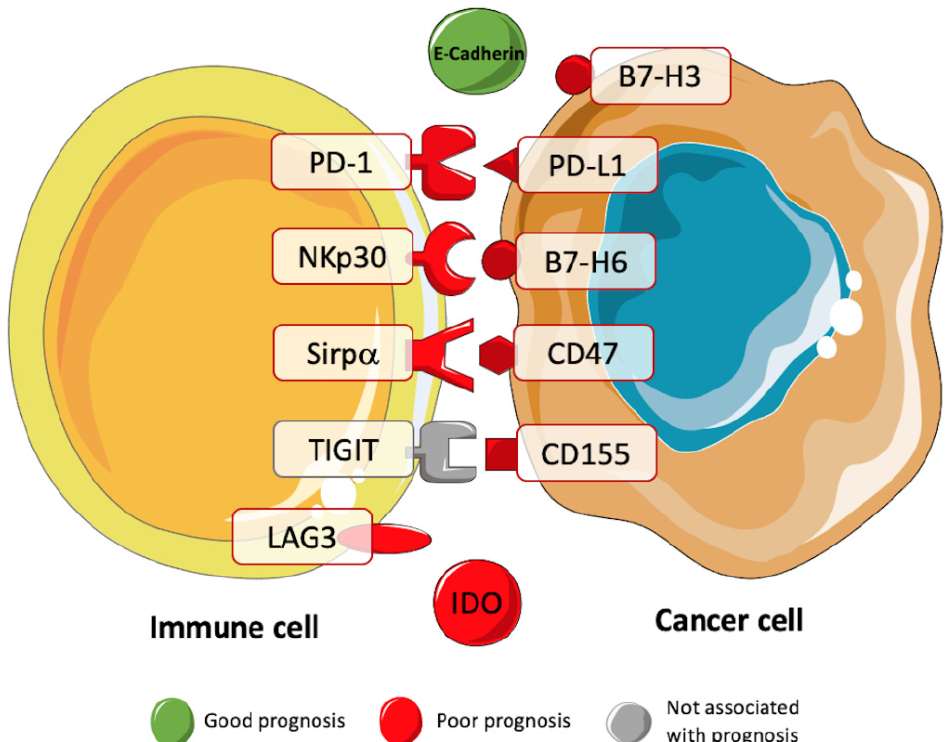
Figure 2. Prognostic value of immune checkpoints in STS. Several studies have been trying to correlate the presence of immune checkpoints with the prognosis of patients with STS. These studies have showed a negative prognostic value for B7-H3, PD-1, PD-L1, NKp30, B7-H6, Sirp α , CD47, CD155, LAG3, and IDO (red). A positive prognostic value was associated with the immune checkpoint E-Cadherin (green) [15,26,39,76–79,89–92].